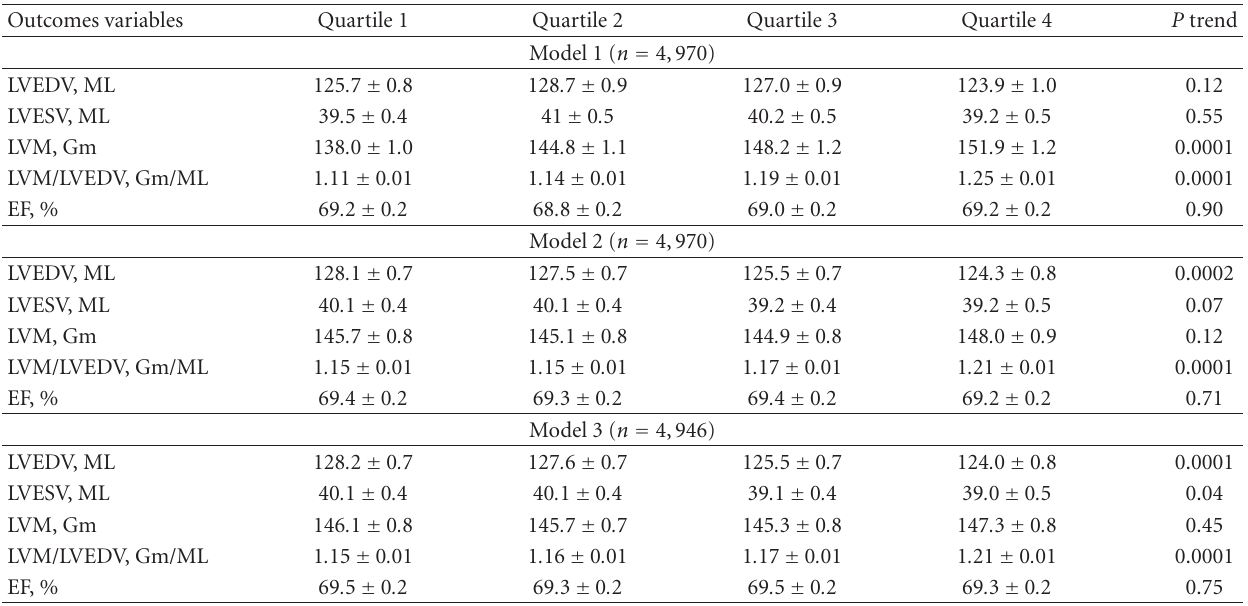
Table 2: The association of cystatin C with LV parameters in nested models showing P trend with increasing cystatin C quartiles. Outcomes variables